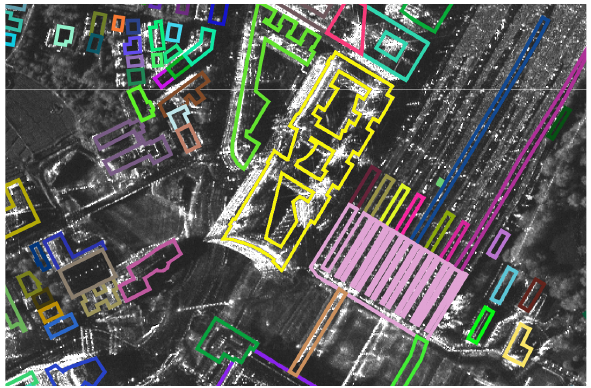
Figure 2. A sample of the geocoded ”HighRes SpotLight 300MHz” scene over Stuttgart, Germany (orbit cycle 119, spot 076). Overlayed with OSM building footprints. Each building